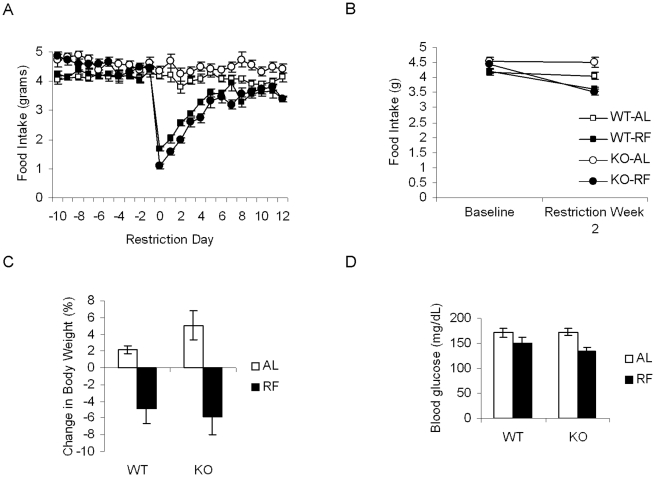
Restricted feeding induces similar changes in food intake, body weight, and blood glucose for both WT and KO mice.A. Daily food intake of WT (squares) or KO (circles) mice assigned to either ad libitum (white) or restricted feeding (black) groups. B. Daily food intake, averaged over the baseline period and second week of restricted feeding. C. Percent change in body weight, calculated from body weight measurements at the end of the baseline period and at the end of fourteen days of restricted feeding. White bars indicate ad libitum feeding conditions, black bars indicate restricted feeding conditions. D. Blood glucose levels measured at the end of fourteen days of restricted feeding. Values represent means ±S.E.M.